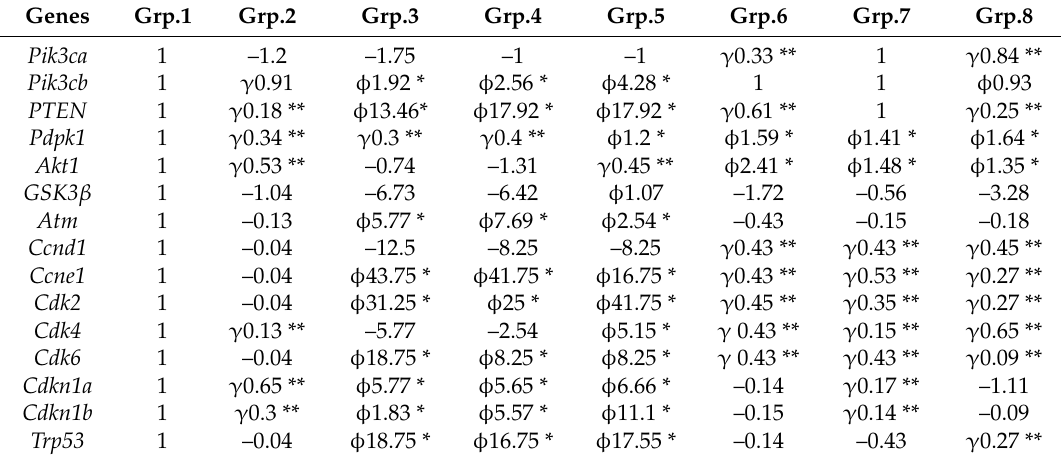
Table 3. Fold change values of the PI3K/Akt-Cyclin D1 genes of each group ( n = 6). Genes